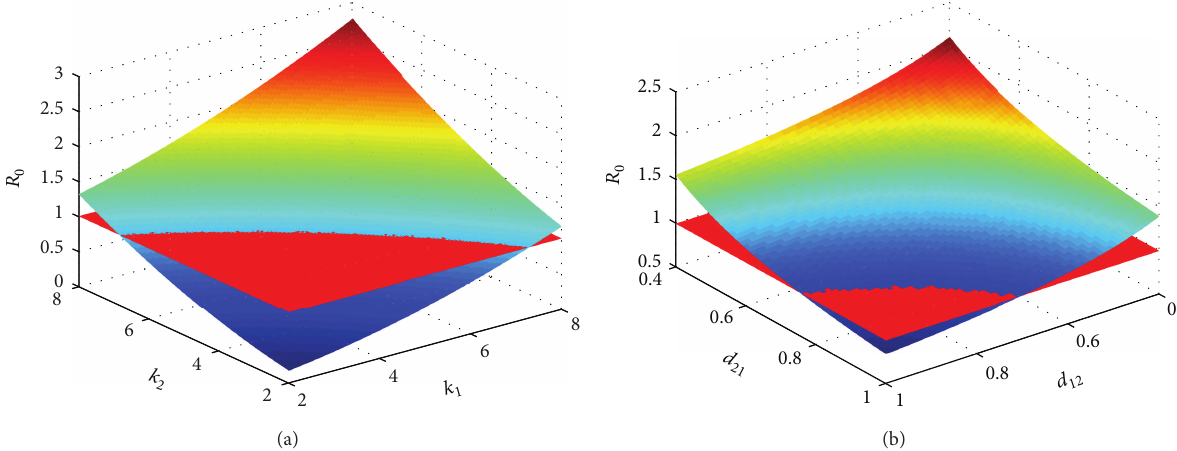
Figure 4: (a) The coopetition threshold 𝑅 0 in terms of 𝑘 1 ,𝑘 2 . (b) The coopetition threshold 𝑅 0 in terms of 𝑑 12 ,𝑑 21